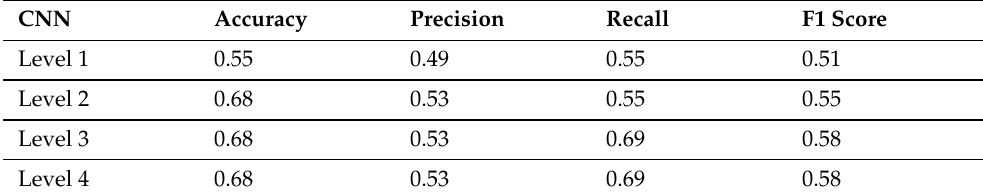
Table 8. Results of CNN at different level of architecture.